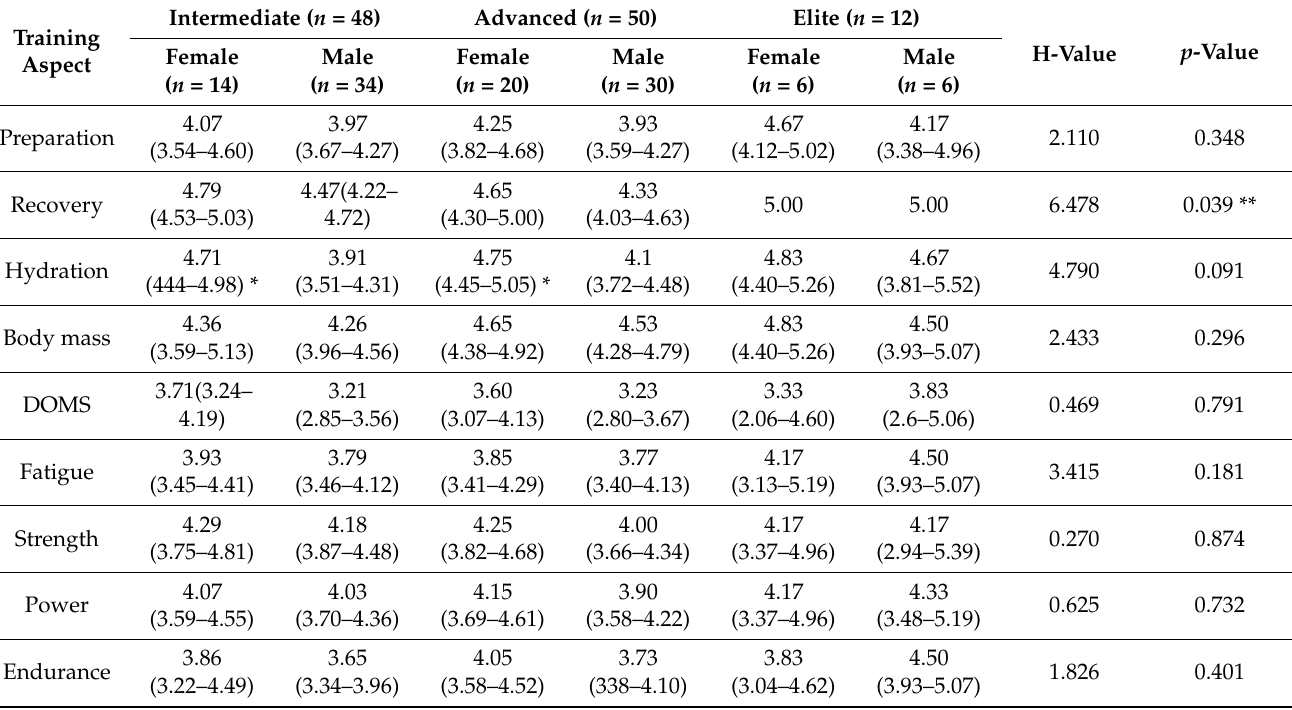
Table 4. Comparison of the perceived importance (1 = not important, 5 = very important) of nutrition for supporting climbing performance. Data presented as mean (95% CI).